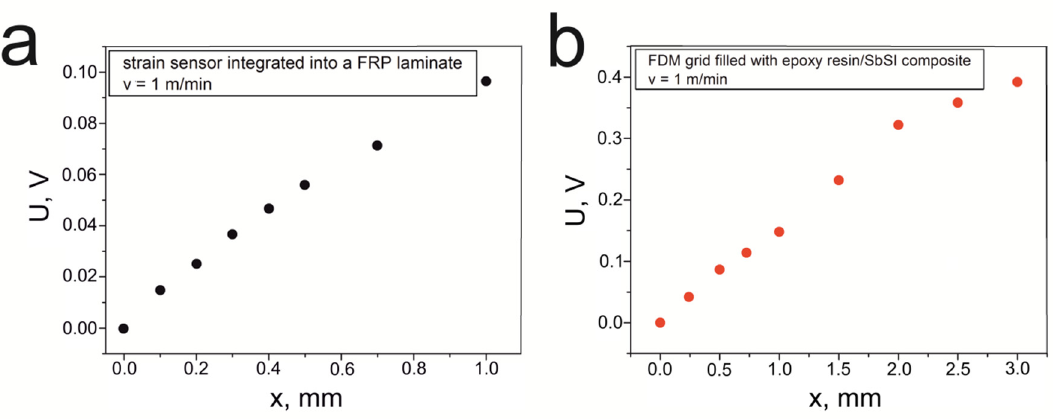
Figure 15. The maximum voltage for various deflections, and a constant deformation speed ( v = 1 mm/min), for ( a ) the strain sensor integrated into an FRP laminate and ( b ) the FDM grid filled with the epoxy resin/SbSI composite.